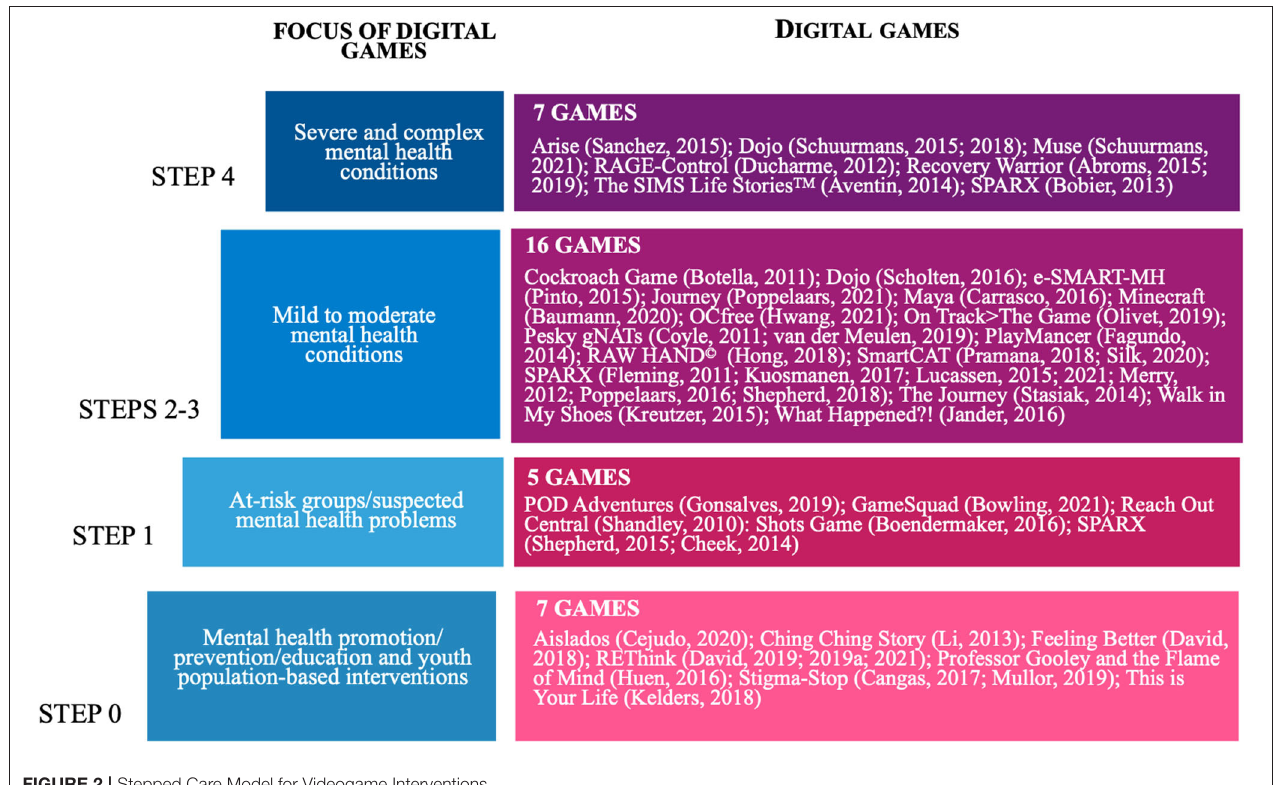
FIGURE 2 | Stepped Care Model for Videogame